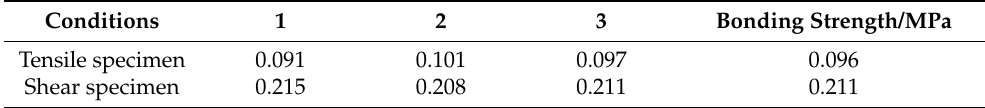
Table 1. The bonding strength of rubber to concrete.